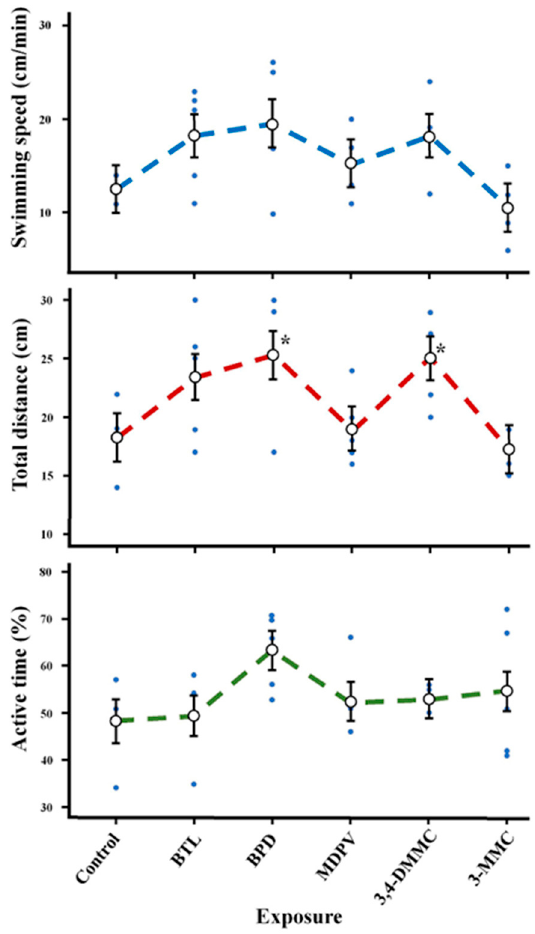
Figure 4. Behavioral effects (swimming speed, total distance travelled and active time) on Daphnia magna at day 5 of exposure to BTL, 3,4-DMMC, 3-MMC, MDPV, and BPD. (Asterisks (*) represent significant differences compared to the control).